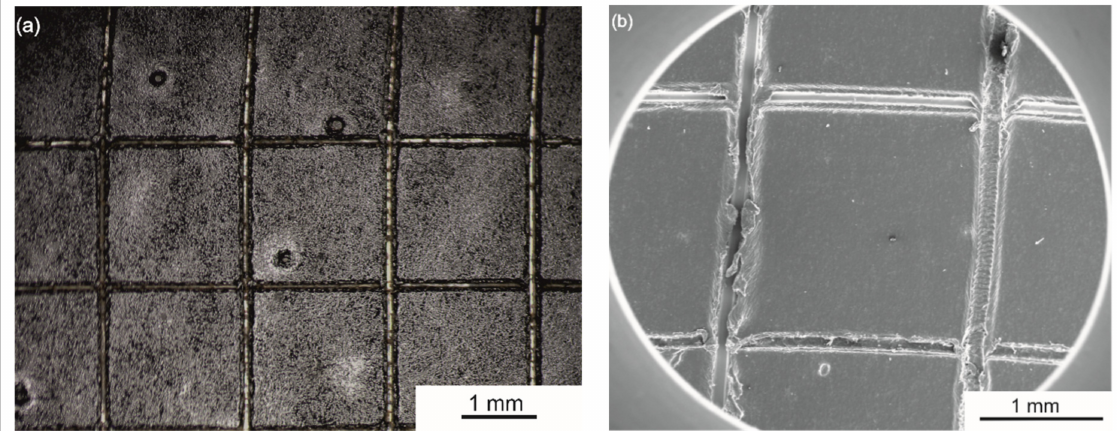
Figure 13. The surface of the n-HA/ZnS/S-PEEK coating ( a ) on the Zr-2.5Nb alloy after tape tests observed with a stereoscopic microscope. The enlarged detail (SEM image) of the cuts is presented in ( b ).